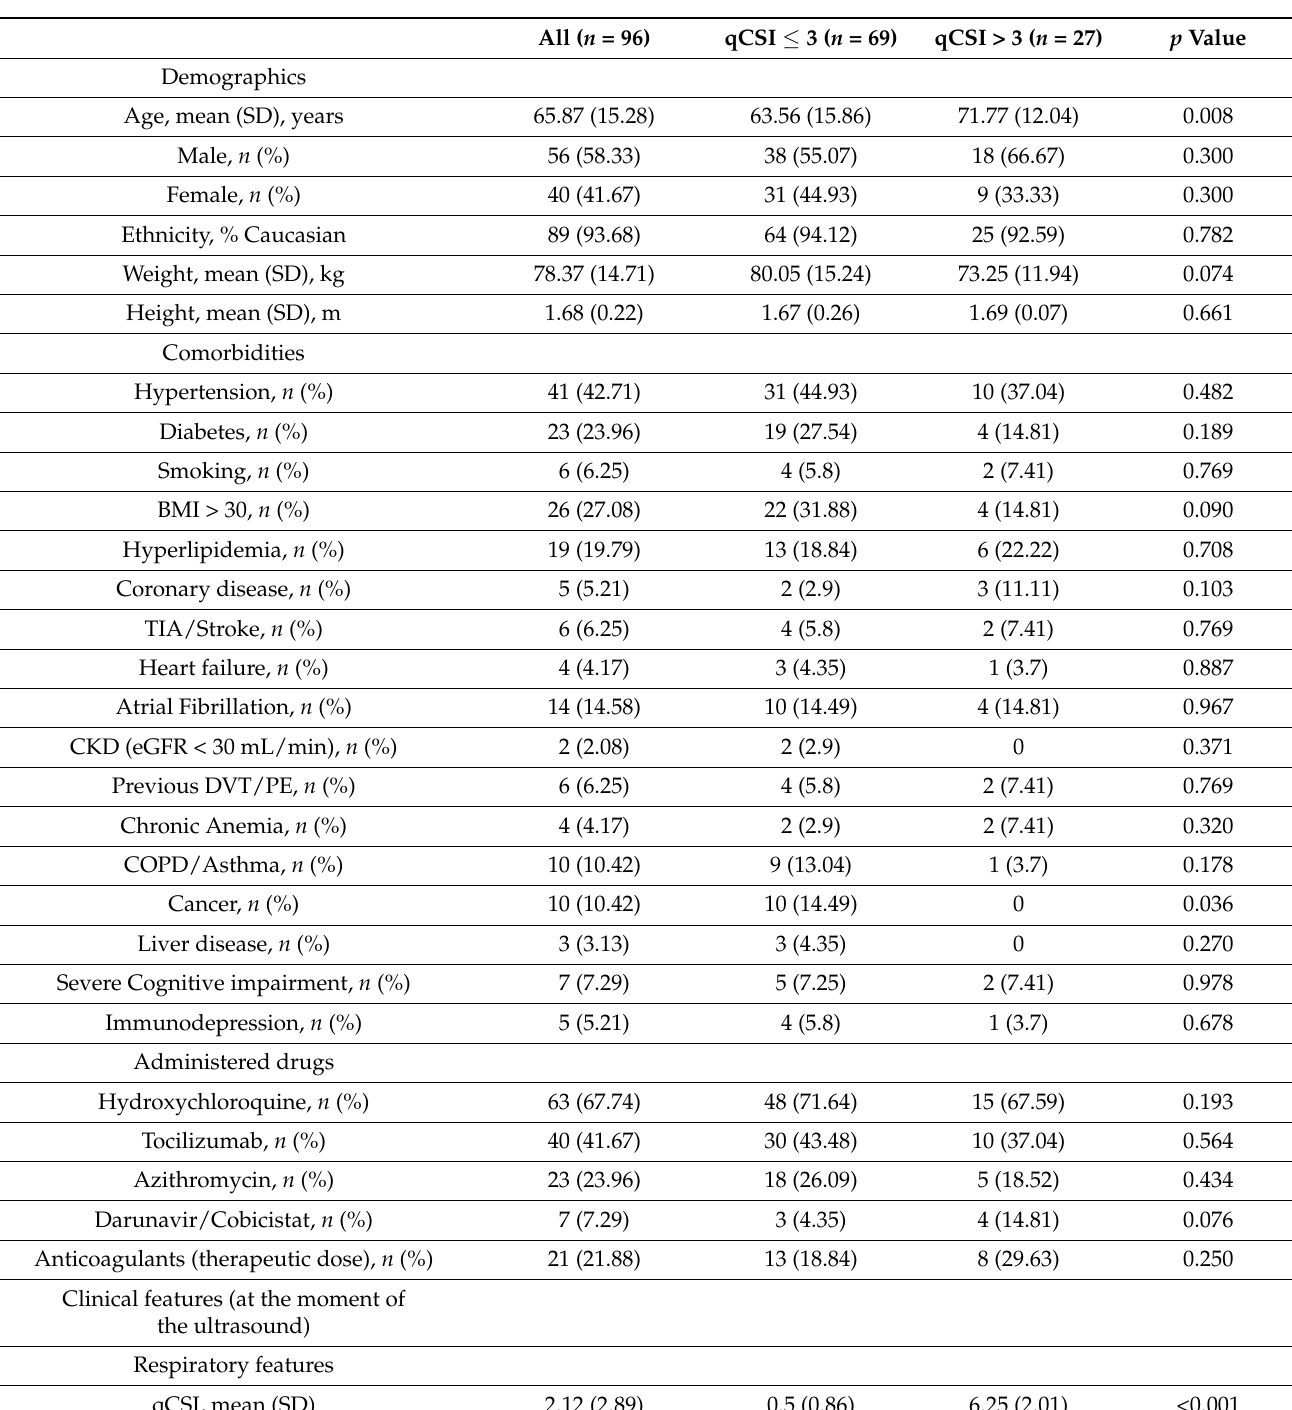
Table 1. Characteristics of the patients distinguished by